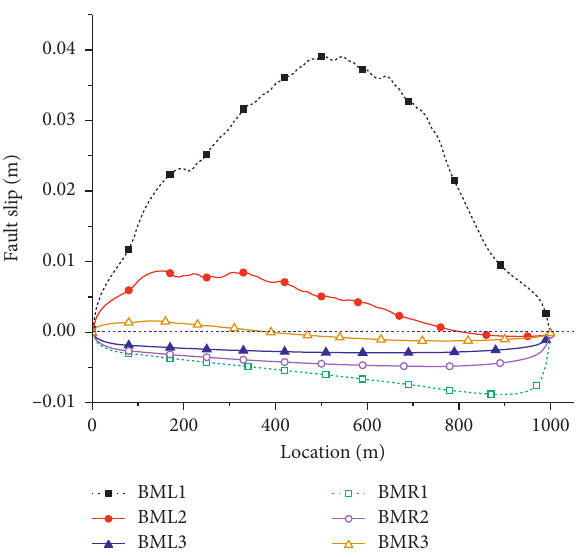
Figure 20: Fault slip along the fault plane when region BM changed in the horizontal